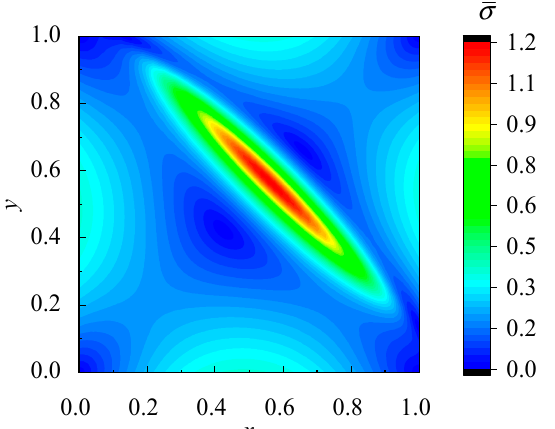
Figure 15. Distribution of effective gradient.